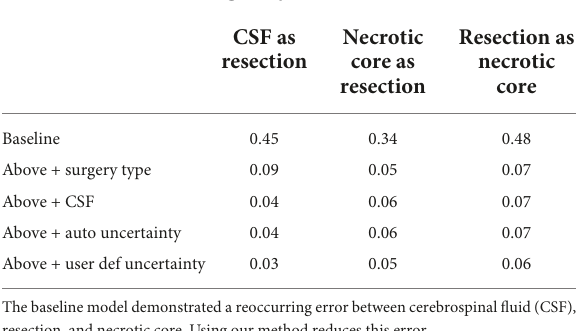
TABLE 2 Rate of mislabeling comparison.